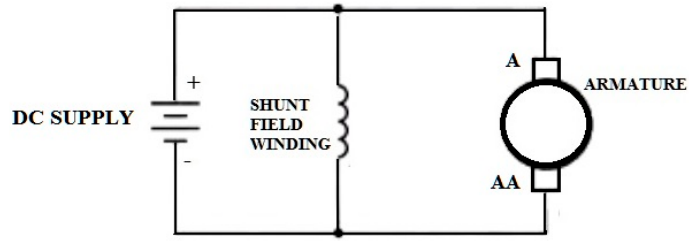
Figure 4. Representation of DC shunt motor.